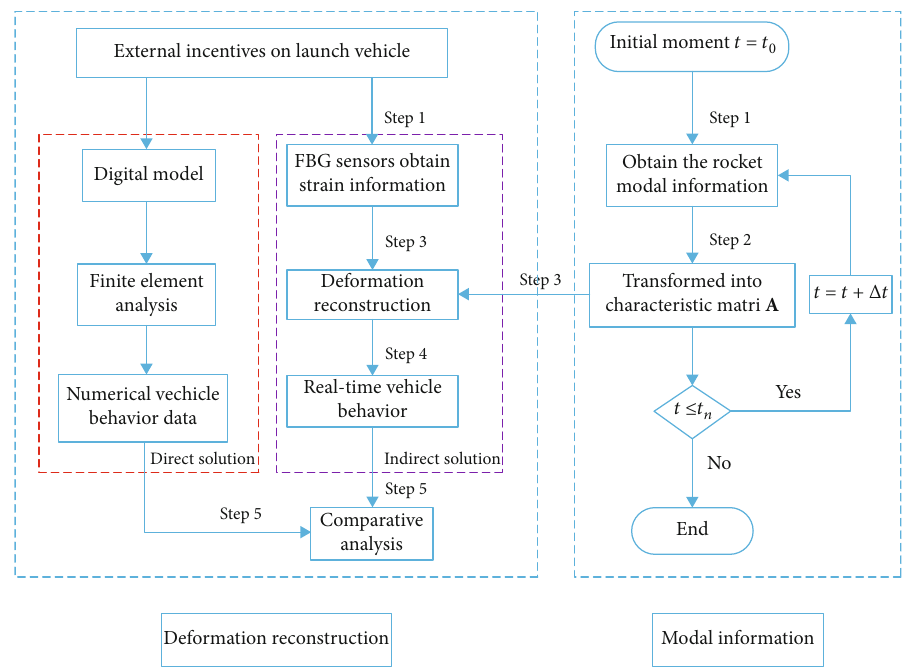
Figure 3: Flowchart of the deformation reconstruction